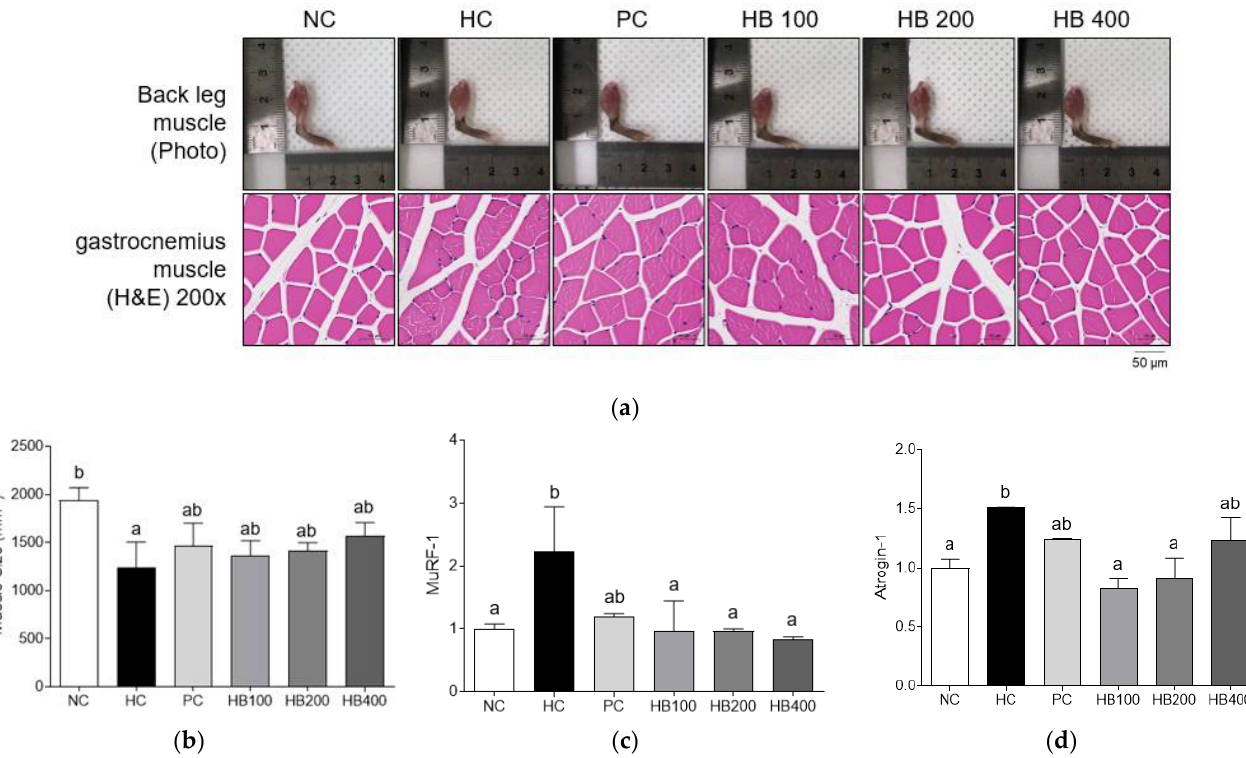
Figure 7. Effects of HB extract on muscle sizes and mRNA expression levels of muscle metabolism related genes. ( a ) Pho- tography of hind limb muscle and H&E staining of gastrocnemius; ( b ) muscle size; ( c ) mRNA expression level of MuRF-1 in the muscle tissue; and ( d ) mRNA expression level of Atrogin-1 in the muscle tissue. Gene expressions were normalized to that of 18S rRNA. NC, Normal diet Control; HC, HF diet control; PC, HF diet with orlistat at 20 mg/kg; HB100, HF diet with honeysuckle berry extract at 100 mg/kg; HB200, HF diet with honeysuckle berry extract at 200 mg/kg; HB400, HF diet with honeysuckle berry extract at 400 mg/kg; Data are presented as mean ± SD ( n = 8). Different letters indicate significant differences by one-way ANOVA ( p < 0.05) followed by Duncan’s multiple range tests.